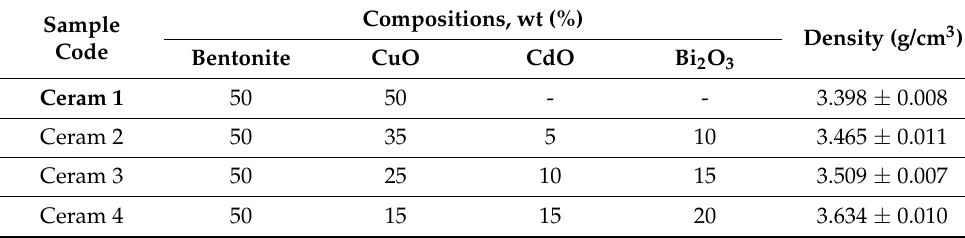
Table 2. Chemical compositions, densities, and codes of the present ceramic